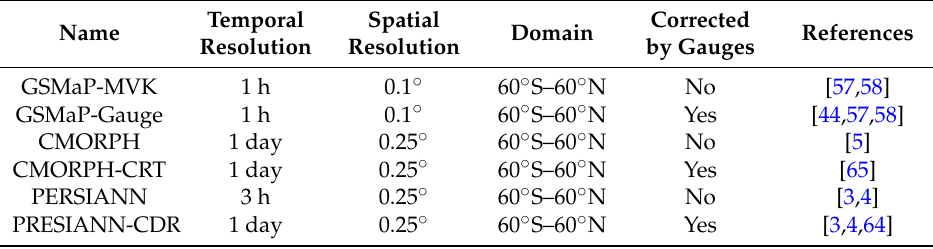
Table 1. Summary of satellite Quantitative Precipitation Estimates